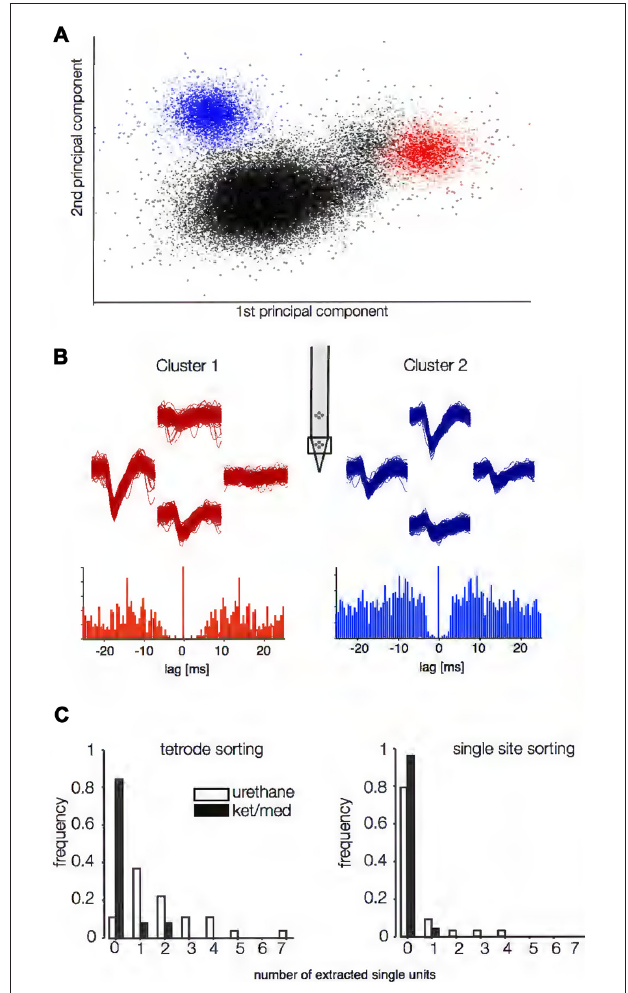
FIGURE 1 | Spike-sorting success under two different anesthetics. Putative single units were judged to be successfully extracted using criteria based on separability of waveforms in principal component space (A) and the shape of the inter-spike interval (ISI) autocorrelation function (B) . In (A) the first two principal components of the spike snippets are plotted for an example recording obtained under urethane anesthesia. In this example, two single units could be successfully extracted (blue and red dots, respectively). In (B) , the autocorrelation functions for the ISIs for the two units are displayed. The traces above the autocorrelation panels show voltage traces at the different sites of the tetrodes (inset) for both units. (C) Spike-sorting success for all recording sites obtained under ketamine/medetomidine (ket/med, n = 52) and urethane ( n = 27) anesthesia. The left panels depict sorting success if all four sites of the tetrode ( B , upper panels) were used ( p = 2.8 ∗ 10 − 10 , Wilcoxon rank-sum test). For the right panel, the same data was analyzed, but using only one site per tetrode for spike sorting ( p = 0.0094, Wilcoxon rank-sum